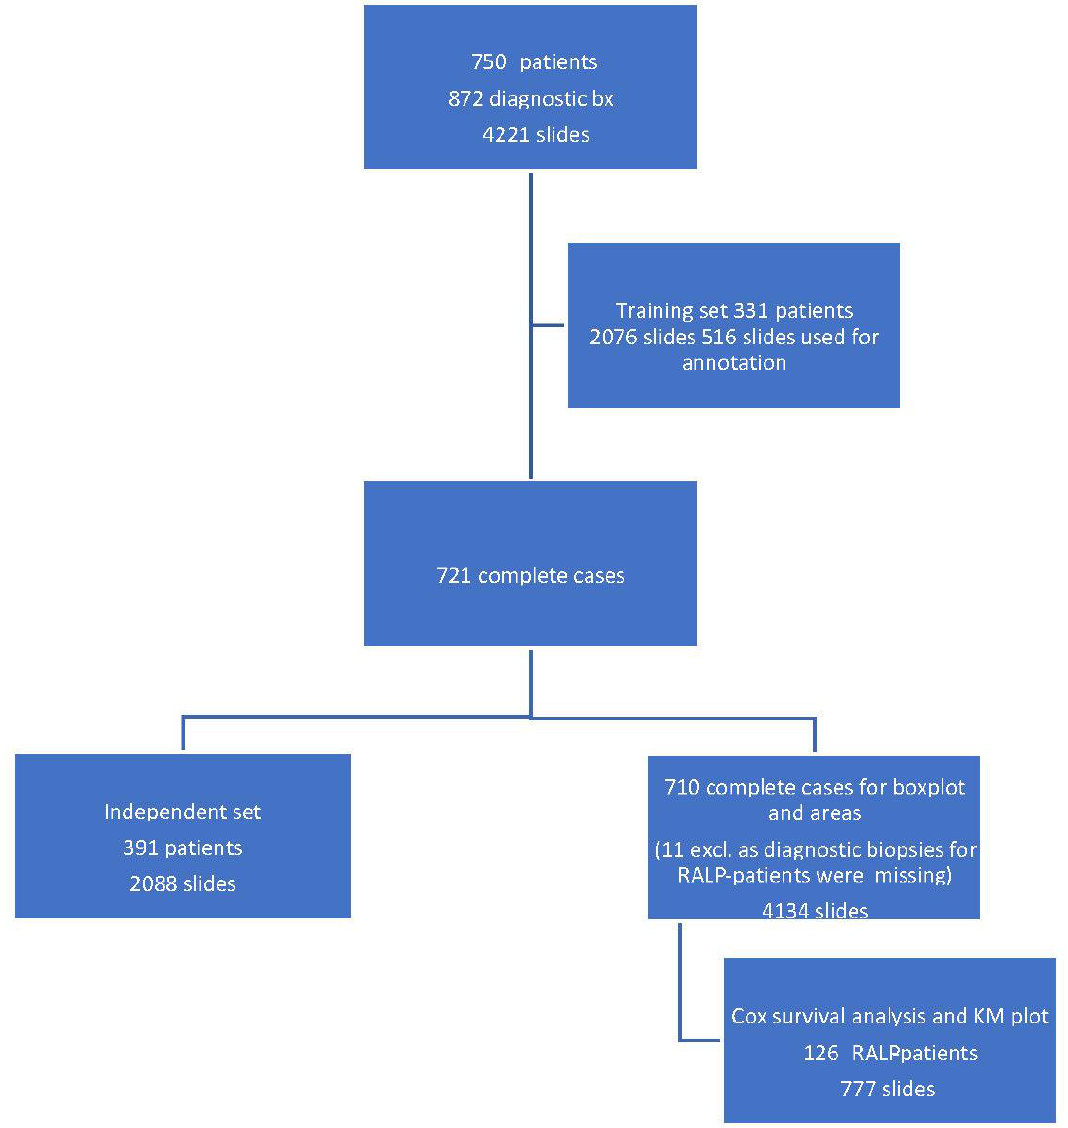
Figure 1. Workflow of the study cohort data selection depicting a training set, an independent set, and radical prostatectomy (RALP) patient cohort from 872 prostate core biopsy